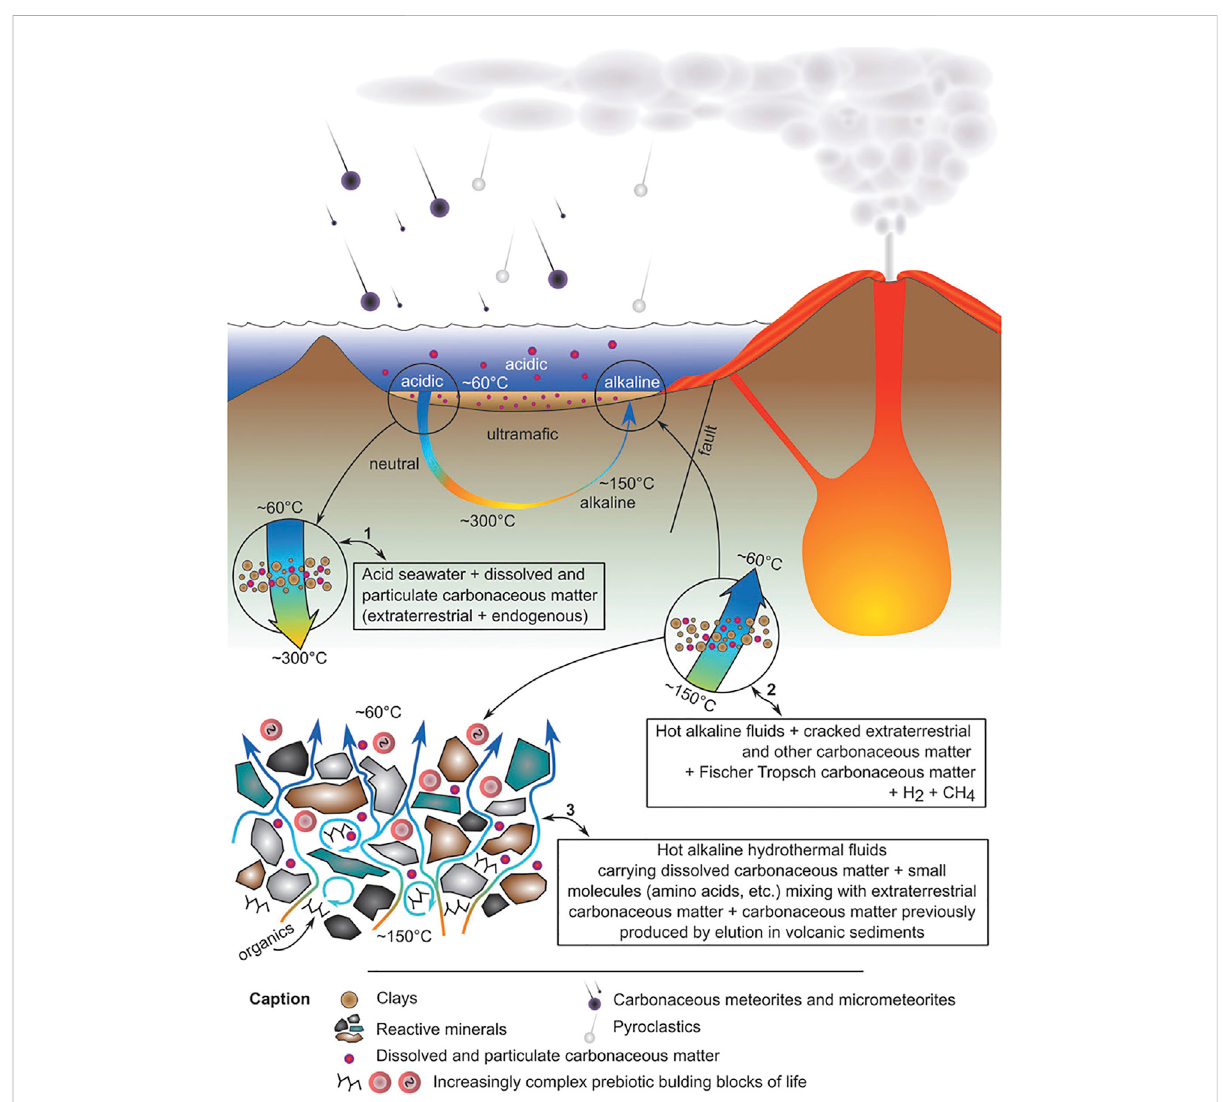
FIGURE 10 Circulation of hydrothermal fl uids through shallow water volcanic sediments on the Hadean/palaeoarchaean Earth (after Westall et al., 2018). This scheme is based on data from well-preserved, Palaeoarchaean rocks of ~3.5 – 3.3 Ga. However, the geo-environmental situation of the Palaeoarchaean is considered to be analogous to that of the latter half of the Hadean, when life is believed to have